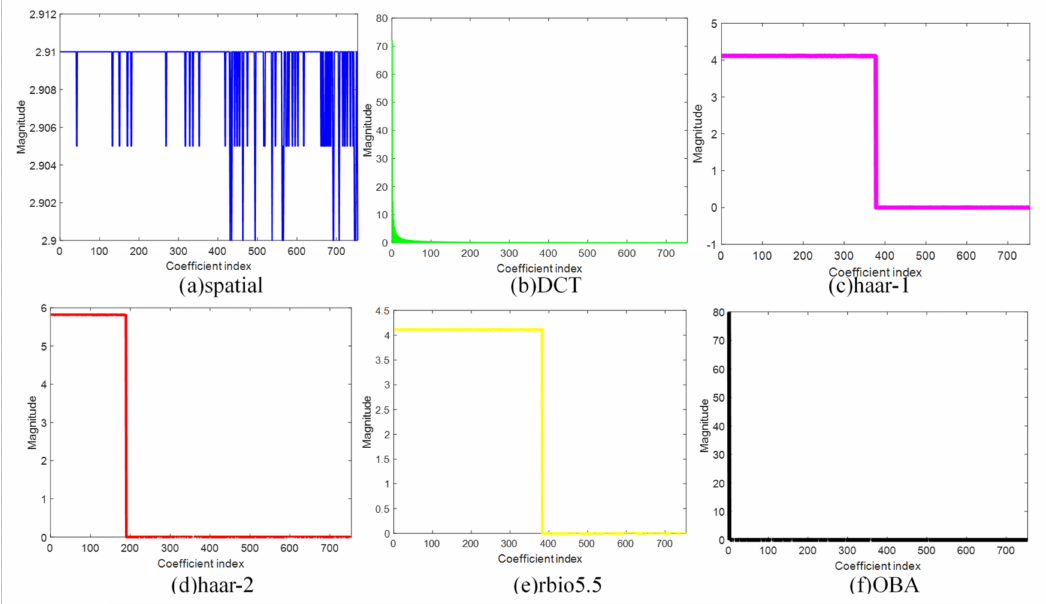
Figure 10. Sparsity performance of voltage of DEI-Campaign B in six various sparse